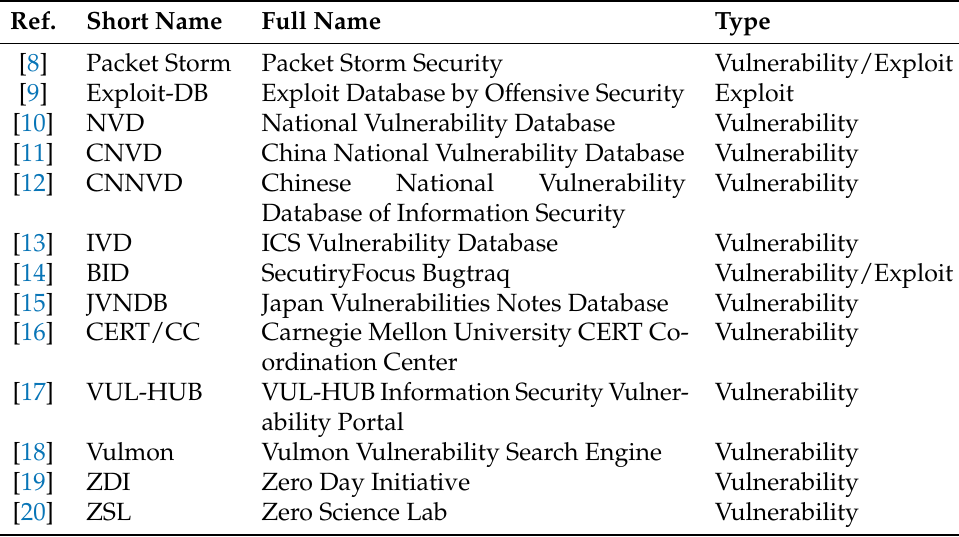
Table 1. Summary of used information